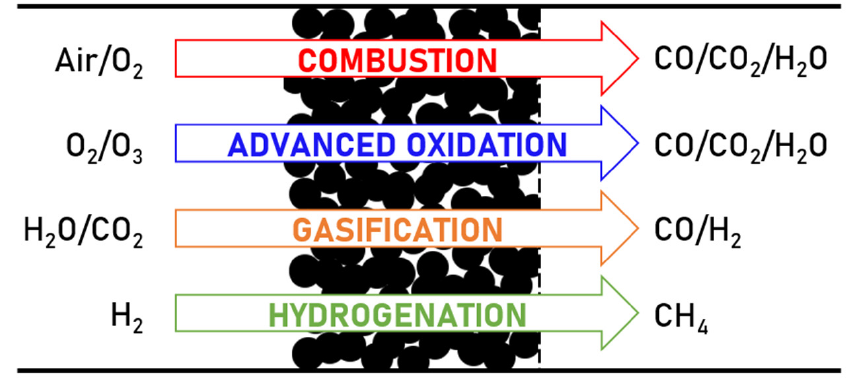
Figure 24. Schematic representation of the main coked zeolites regeneration methods with the principal generated products.